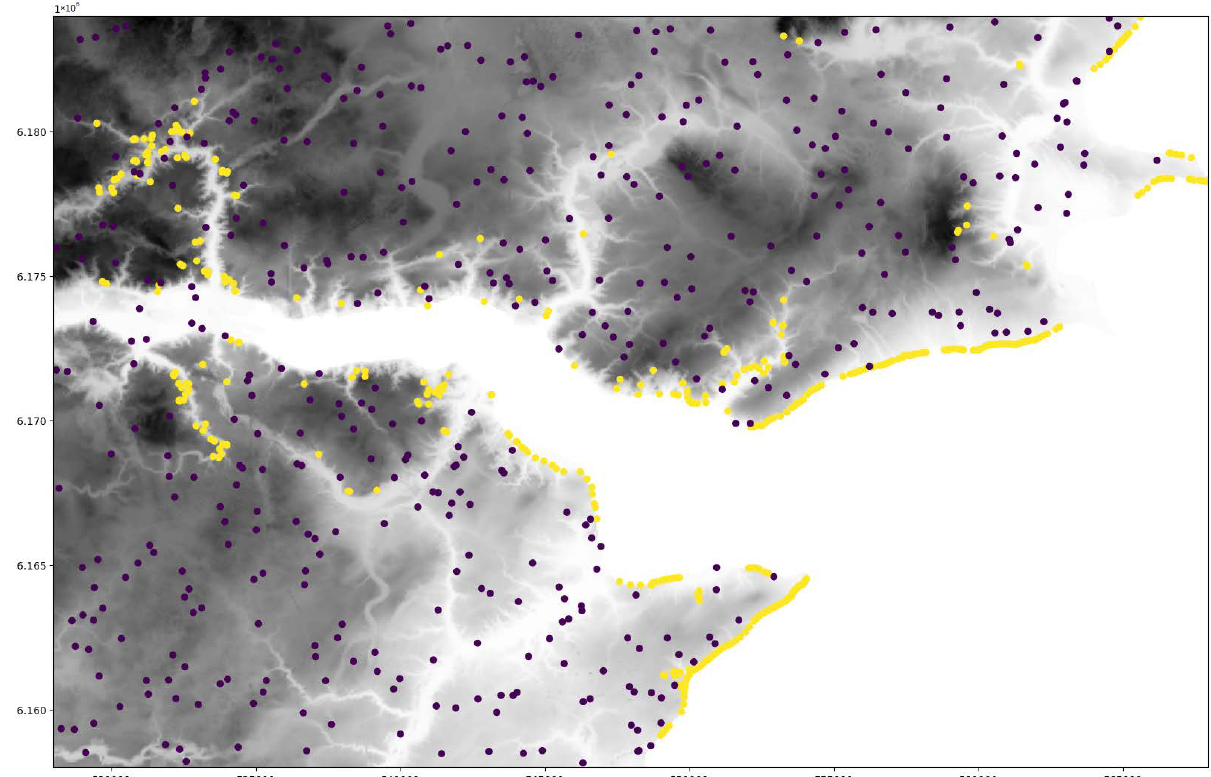
Figure 2. Overview of the centroid points of landslides (yellow) and an equivalent amount of randomly sampled non-landslide points